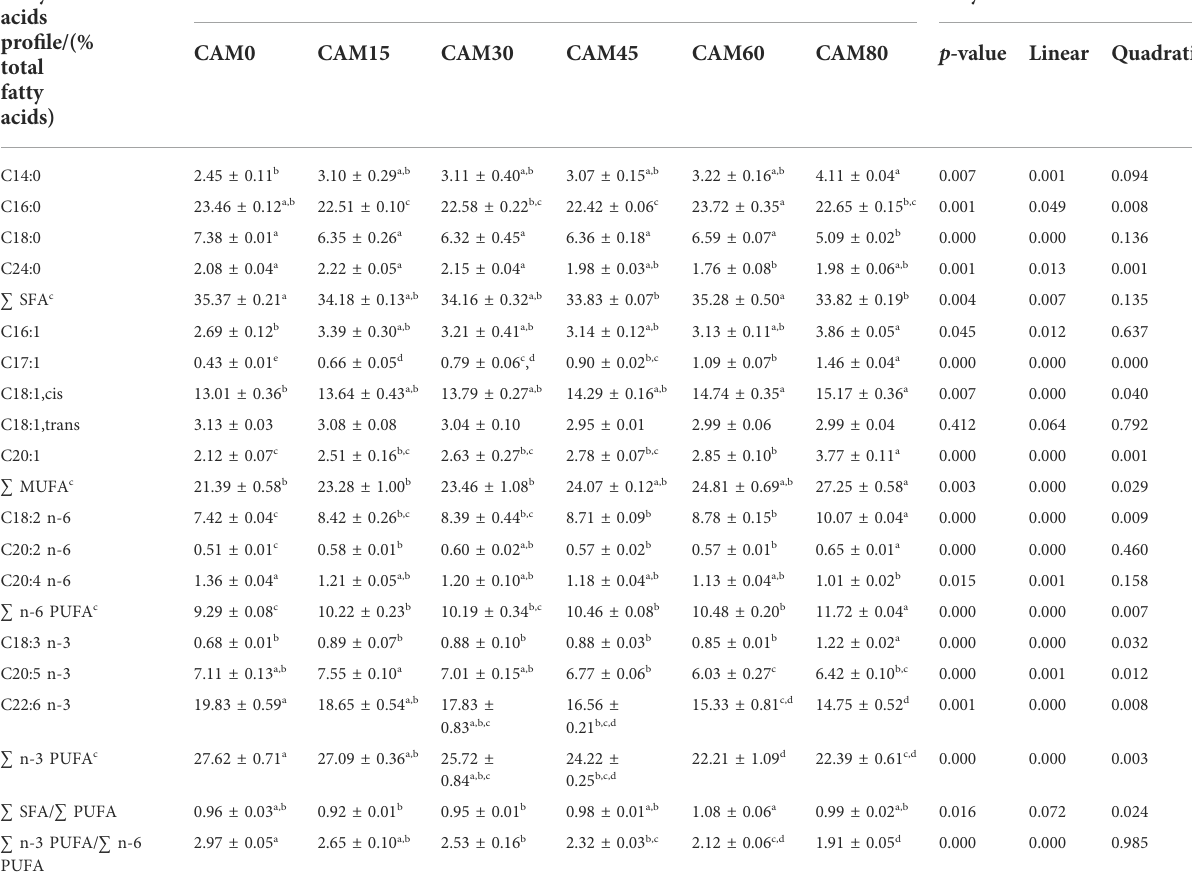
TABLE 8 Fatty acids pro fi le in dorsal muscle of juvenile turbot (Means ± S.E.M) a . Diets b Polynomial contrasts Fatty acids pro fi le/(% CAM0 CAM15 CAM30 CAM45 CAM60 CAM80 p -value Linear total fatty acids)